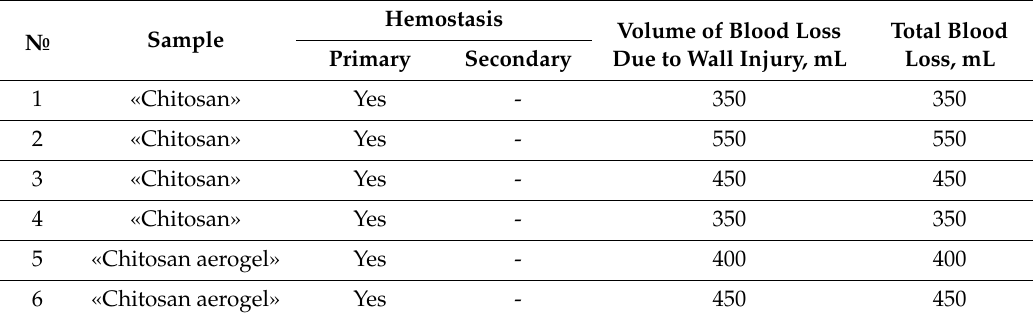
Table 2. The E ff ectiveness of Various Local Hemostatic Agents on a Model of Arterial Bleeding from the Large